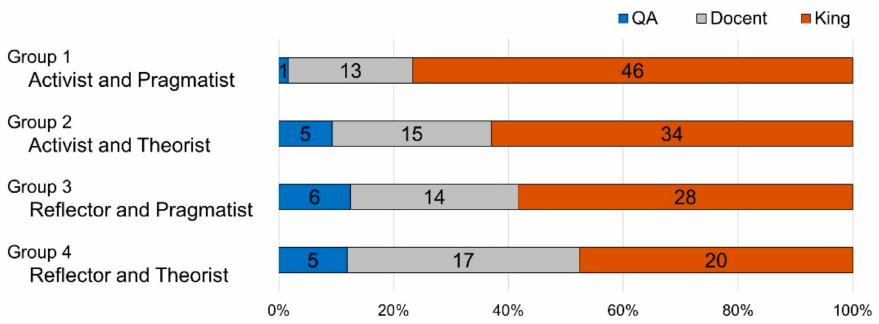
Figure 4. MES results with respect to learning style. (upper: Activist vs. Reflector, lower: Pragmatist vs. Theorist). (significance p -value *: p < 0.05, **: p < 0.01, ***: p < 0.001).